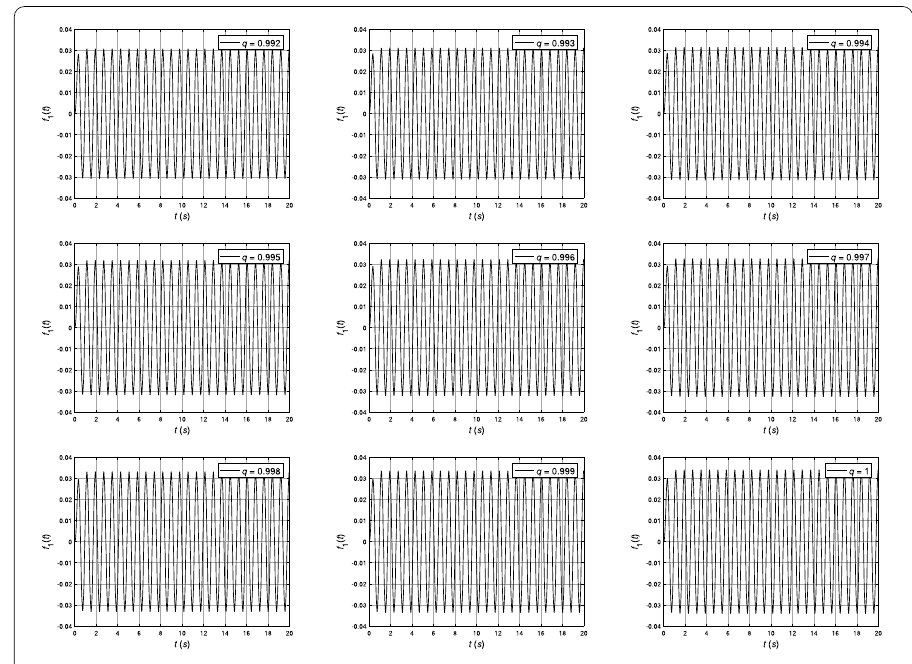
Figure 4 The state variable f 1 ( t ) of the controlled system (34) for q = 0.992,0.993,0.994,0.995,0.996, 0.997,0.998,0.999,1